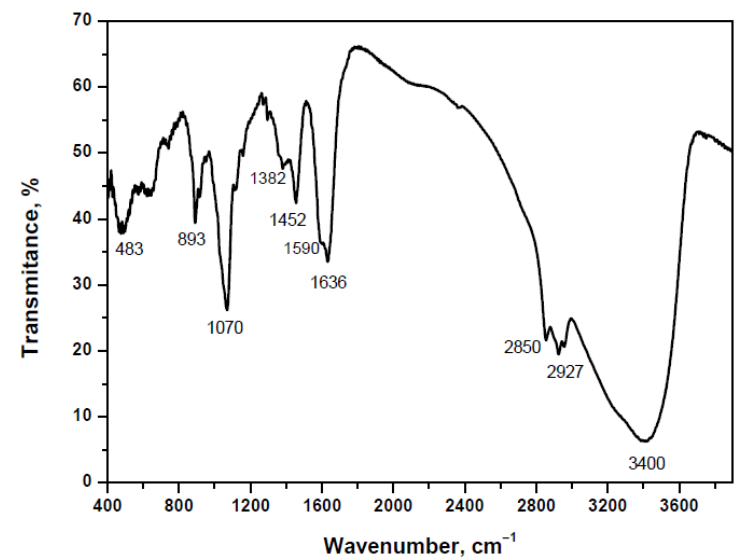
Figure 11. FTIR spectrum of the isolated and dried